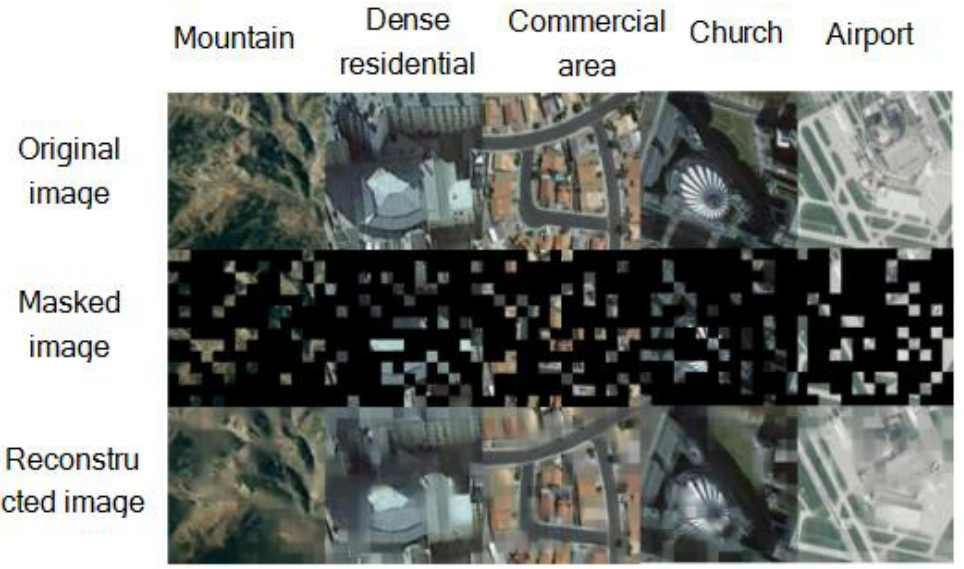
Figure 3. Pixel reconstruction results of self-supervised learning pre-trained model on NWPU data